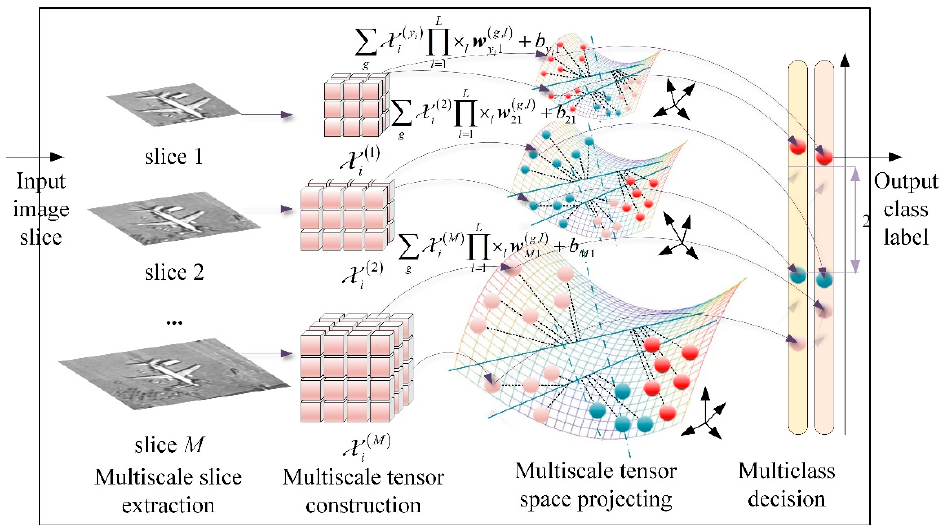
Figure 2. Illustration of objects classification for MCMS-STM.